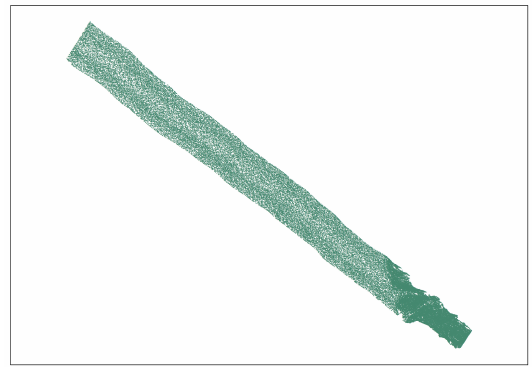
Figure 18. DDR thinning method of 16% thinning